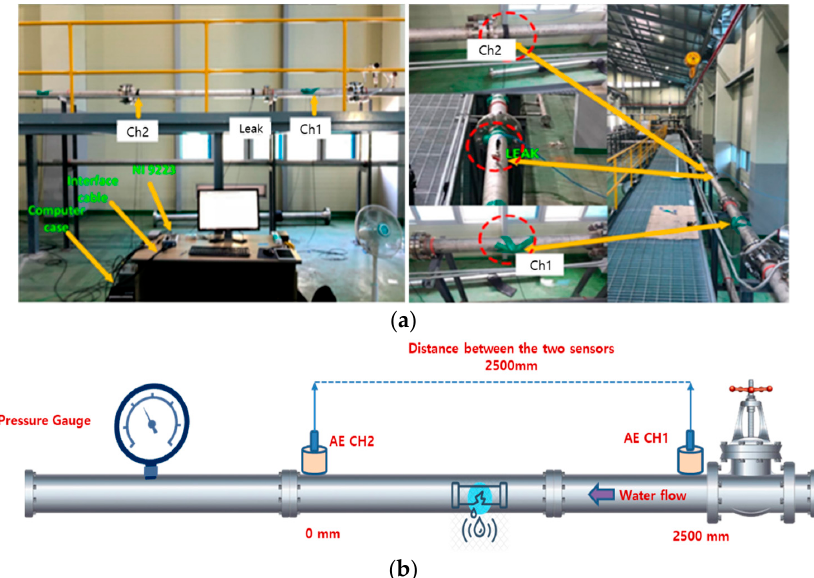
Figure 7. Experimental setup used for simulating leaks in the pipeline: ( a ) photo and ( b ) schematic.